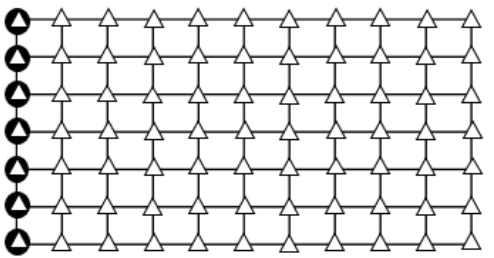
Figure 3. Illustration of the discrete unknowns at an N × M mesh, the left black dots are the locations of φ (cid:48) and ζ (cid:48) , the congruent triangles are the locations of the φ (cid:48)